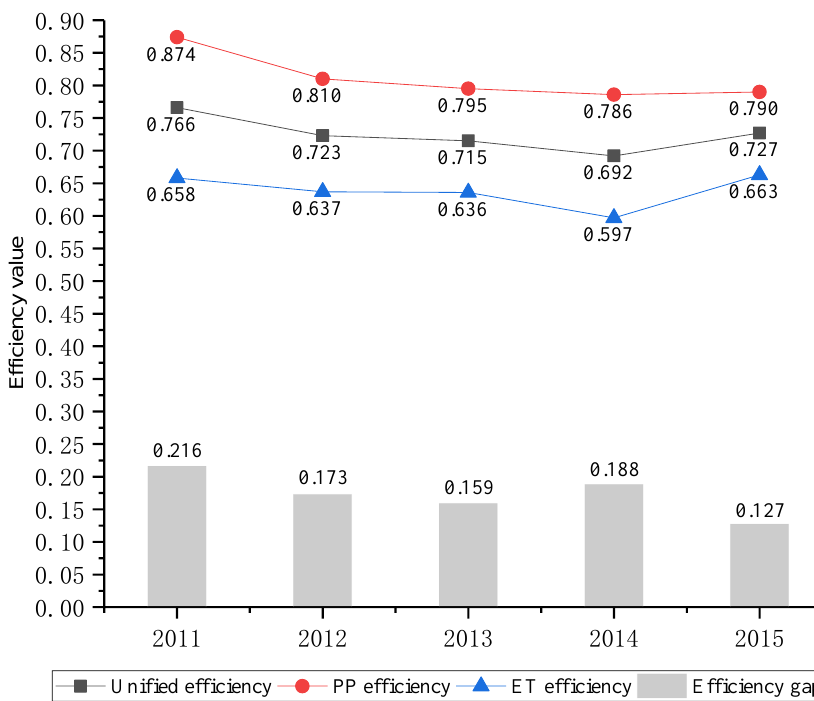
Figure 4. The annual efficiency change and gap.